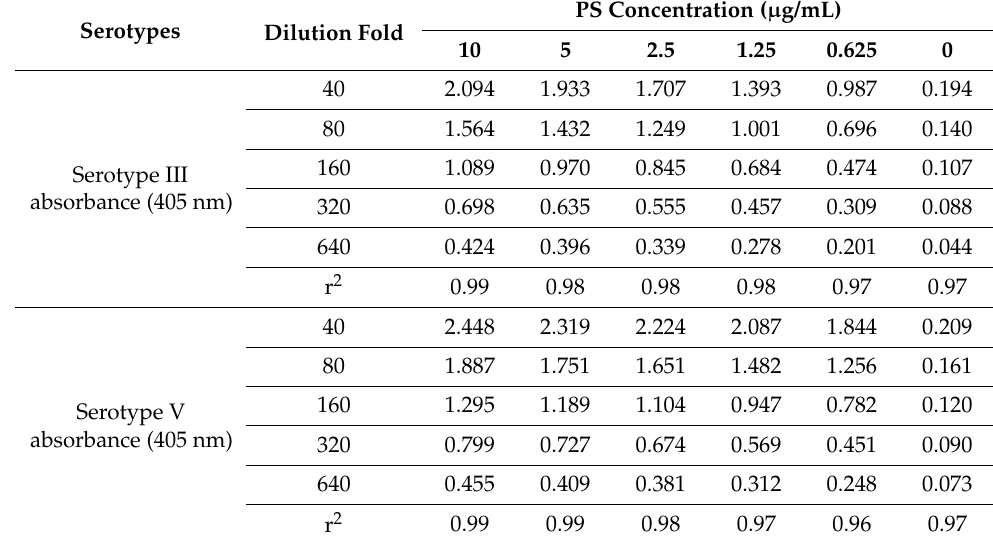
Figure 2. Schematic overview of enzyme-linked immunosorbent assay (ELISA) to measure group B Streptococcus (GBS) polysaccharide (PS)-specific IgG. To reduce non-specific binding, samples were reacted with inactivated non-encapsulated GBS before ELISA. Subsequent steps were performed according to the pneumococcal ELISA protocol. PS, polysaccharide; RT, room temperature; AP, alkaline phosphatase.